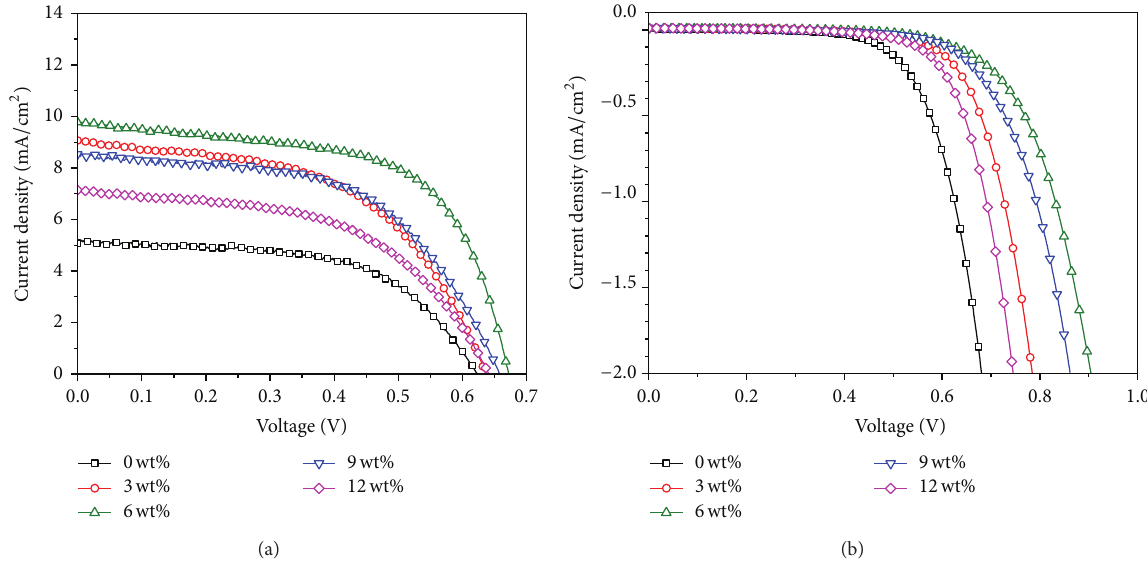
Figure 5: The 𝐽 - 𝑉 curves of DSSCs with composite electrolytes containing various contents of VMT (a) under simulated AM 1.5 solar spectrum irradiation at 100mW cm −2 ; (b) in the